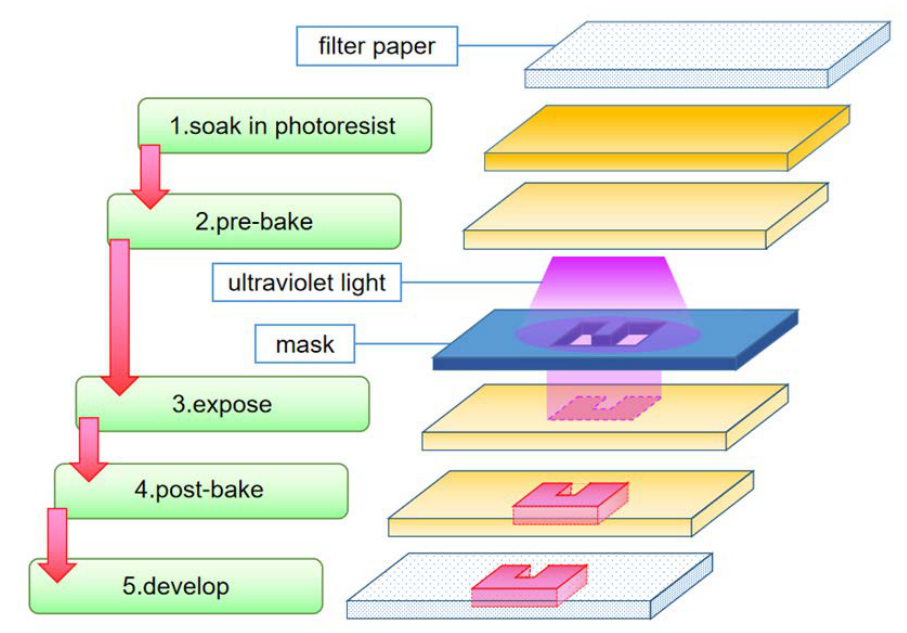
Figure 1. Schematic diagram of paper chip preparation using photoresist.